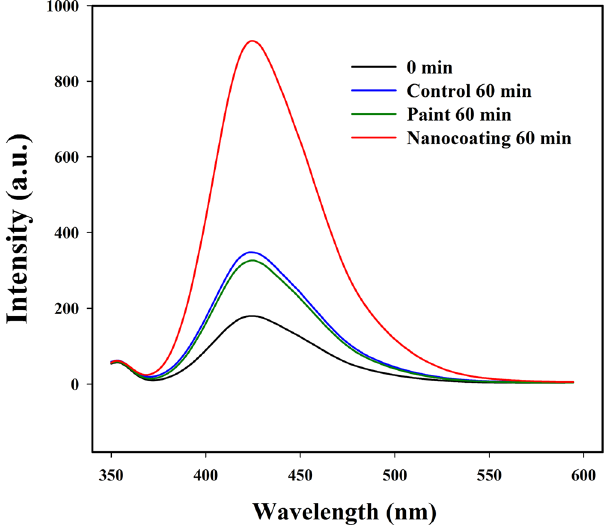
Figure 2. Photoluminescence spectra of Terapthalic acid after treatment with coatings. Photoluminescence spectra of Terapthalic acid treated with control, nanocoated and painted net substrate illuminated by solar stimulator for 1